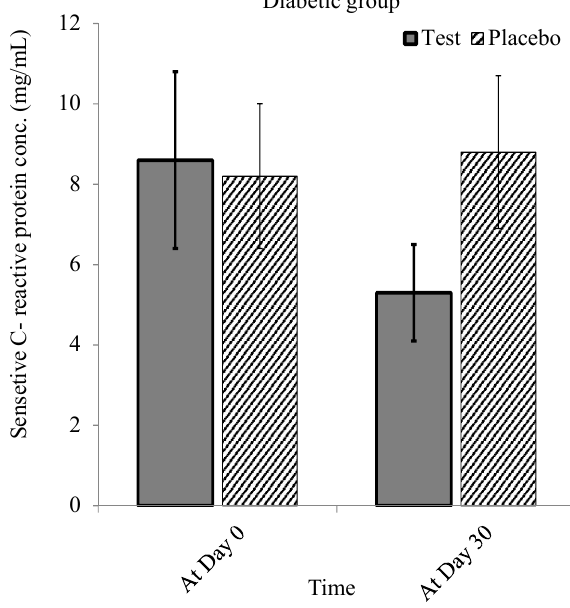
Fig. 5. Sensitive C-reactive proteins levels for the diabetic group receiving anthocyanin extract or